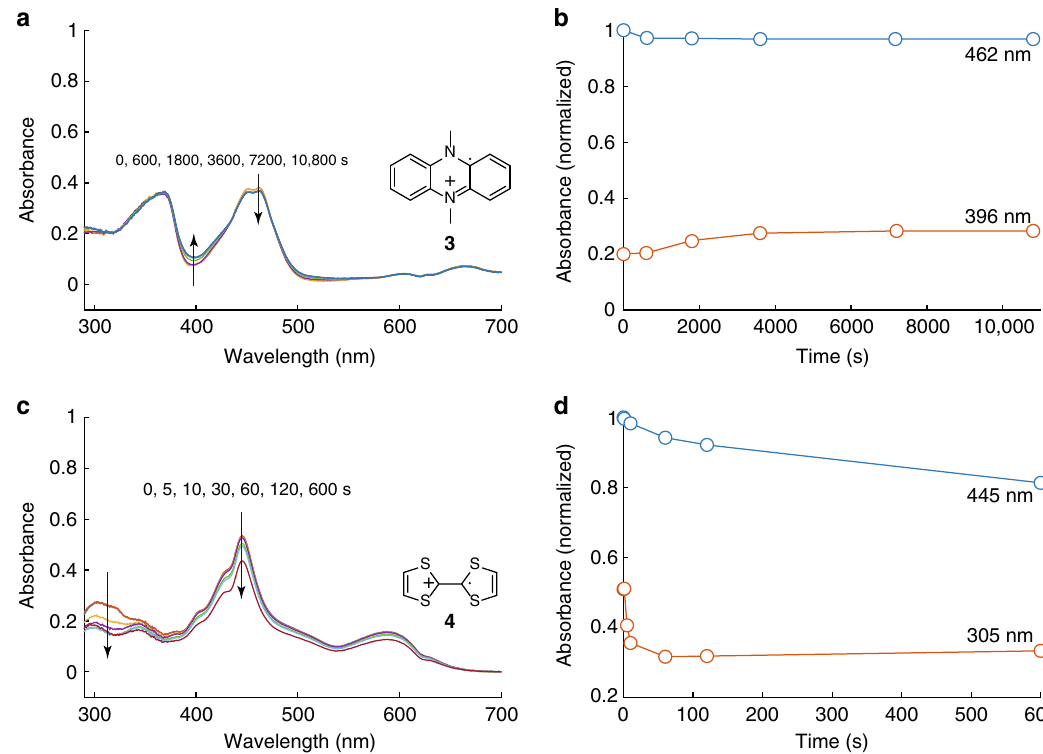
Fig. 3 Stability of oxidized redox mediators against singlet oxygen. UV-Vis spectra of DMPZ + ( a ) and TTF + ( c ) upon exposure to 1 O 2 as well as the normalized absorbance of DMPZ + ( b ) and TTF + ( d ) vs. time, as extracted from the positions indicated. DMPZ + or TTF + were generated by electrochemically oxidizing 0.02M DMPZ or TTF, respectively in TEGDME electrolytes containing 0.1M LiTFSI, followed by extraction into TEGDME to form a 250 µ M solution. µ M palladium(II) meso -tetra(4- fl uorophenyl)-tetrabenzoporphyrin and illumination at 643nm, 1 O 2 was photogenerated in the O 2 -saturated solution using 1 and the spectra were measured after the illumination times indicated. The spectrum of the sensitizer has been subtracted from a and c